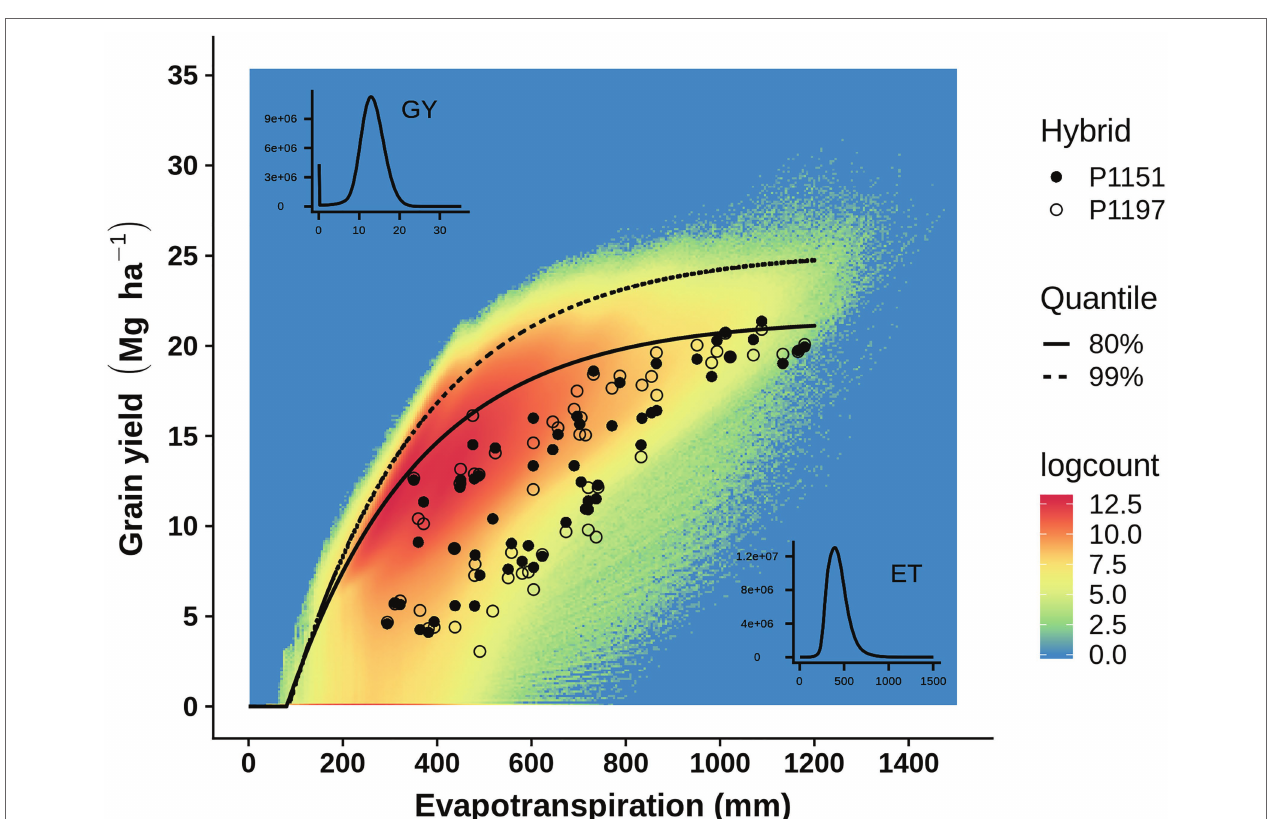
FIGURE 2 | Enviromics applied to assess how well a MET represents a target population of environments (TPE). Example of empirical grain yield results from a maize MET compared to GxExM expectations for the US corn-belt TPE. To compare the empirical MET results and modelled TPE expectations, environments were characterized in terms of crop evapotranspiration to quantify the gradient from water-limited (low evapotranspiration) to water-sufficient environments (high evapotranspiration). Enviromics approaches were applied to the environments sampled in the MET to obtain the inputs for a crop model, which was used to estimate crop evapotranspiration following Cooper et al. (2020). The MET example focuses on the yield comparison between two hybrids, P1197 (Responsive; Figure 1 ) and P1151 (Stable; Figure 1 ). The empirical yield-evapotranspiration results for the MET are superimposed on the simulated cloud of yield- evapotranspiration outcomes for the TPE. The estimates of the 99th and 80th percentile yield-evapotranspiration fronts for the TPE provide a reference for interpreting the empirical yield-evapotranspiration results hybrid reaction-norms obtained for the MET. Whenever the empirical yield for a GxExM combination falls below the 80th percentile yield-evapotranspiration front a yield-gap is associated with the on-farm yield. The empirical results from the MET can then be analyzed to identify on-farm situations where the yield-gap can be reduced by choice of genotype (e.g., stable or responsive), agronomic management (e.g., plant density, irrigation strategy), or genotype–management technology